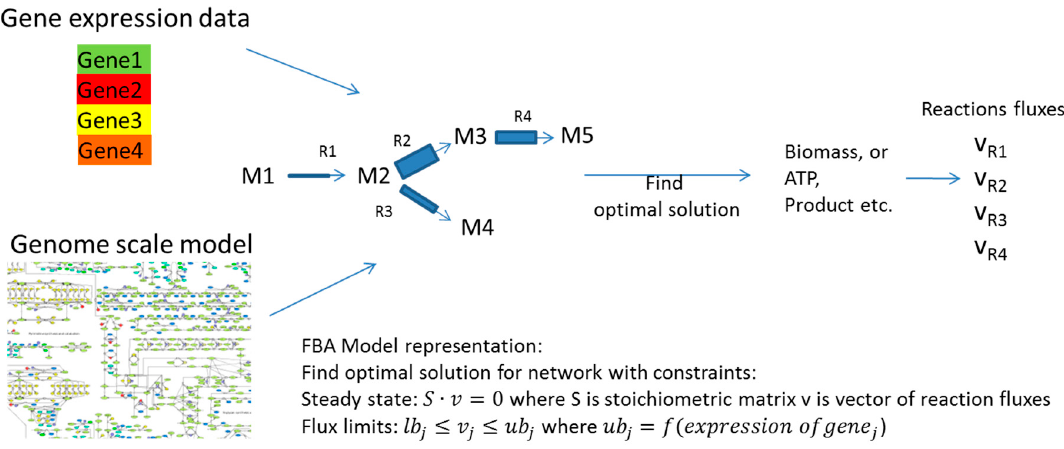
Figure 4. In the examples presented by [71,72], gene expression data are used to define the upper limit for fluxes across reactions catalyzed by that gene. Further flux optimization is subsequently possible with different methods including machine learning, as shown in Figure 3.